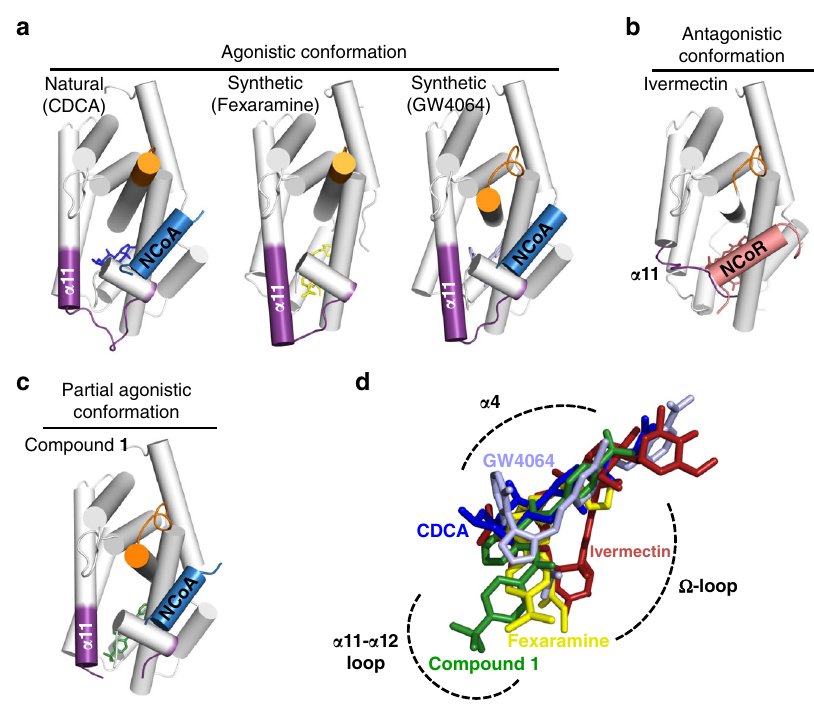
Fig. 3 FXR-LBD – ligand/activator (blue)/repressor (light-red) interactions. a (left) The natural FXR agonist CDCA (blue) stabilises α 11- α 12 (AF2-loop) and α 12 (AF2-helix) while the α 11 (purple) is partially formed. a (middle, right) Binding of the synthetic agonists fexaramine (yellow) and GW4064 (light blue) has a profound effect and extends the length of the α 11. b Binding of ivermectin, destabilises the AF2-loop and in particular the α 11 and the Ω -loop. The ivermectin containing FXR-LBD structure is complexed with NCoR-1 and thus represents an antagonistic conformation not fully re fl ecting ivermectin ’ s biological activity on FXR. c The partial agonist 1 by disturbing the AF2-loop in fl uences the position of the AF2-helix and thereby affects position, orientation and binding of NCoA. In all structures a – c the α 3- α 4 loop is depicted in orange and the ligands are shown as sticks. d Overlay of the binding modes of different ligands. Key protein regions affected due to the ligand binding are highlighted with